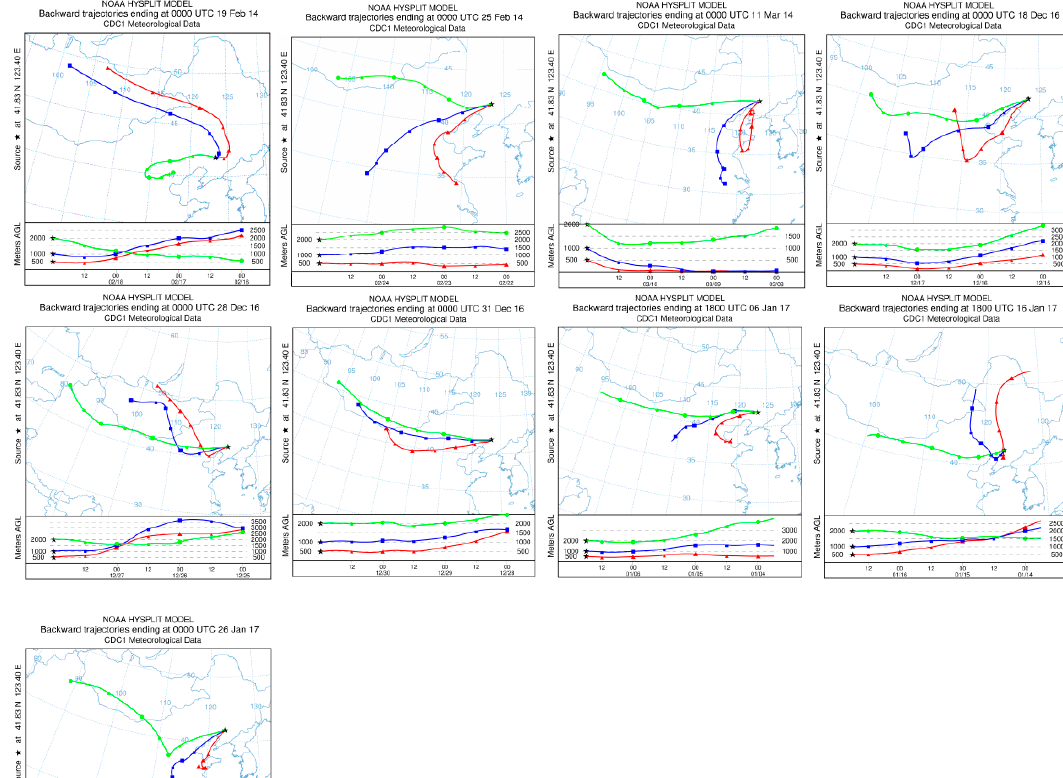
Figure 5. Mean 72-h backward trajectories of pollutions Episodes 1–9 (red, blue, and green lines represent air masses 500, 1000, and 2000 m above sea level, respectively).